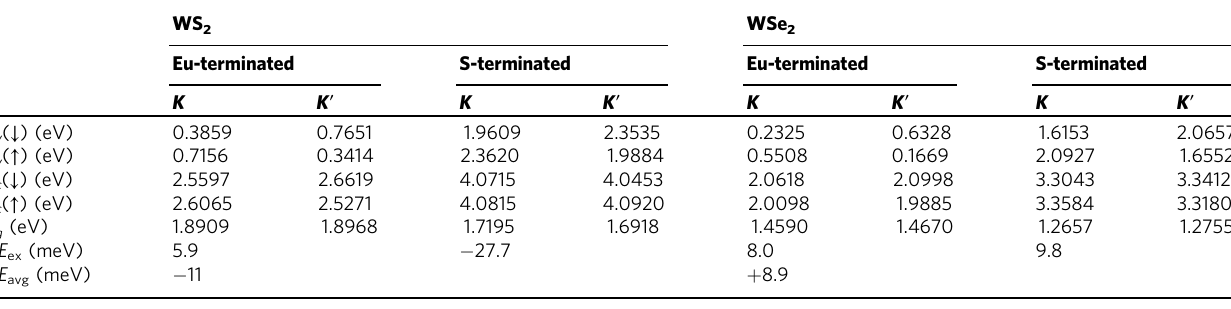
Table 2 K and K ′ valley energies for the top valence and bottom conduction W d-states bands for each spin WS 2 WSe 2